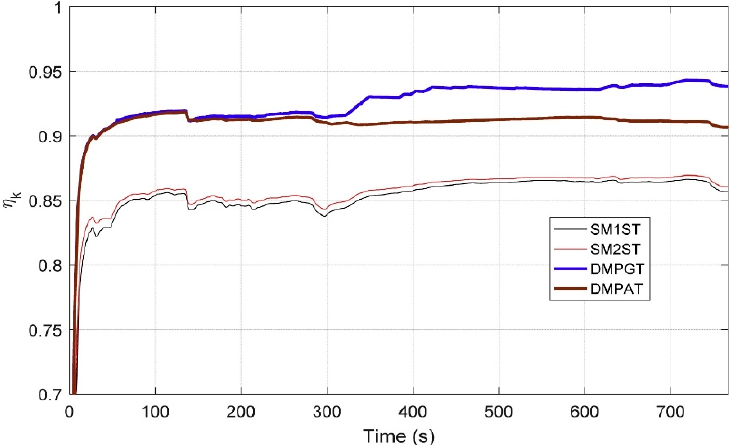
Figure 2. Efficiency of different powertrain configurations [55] with permission of authors.